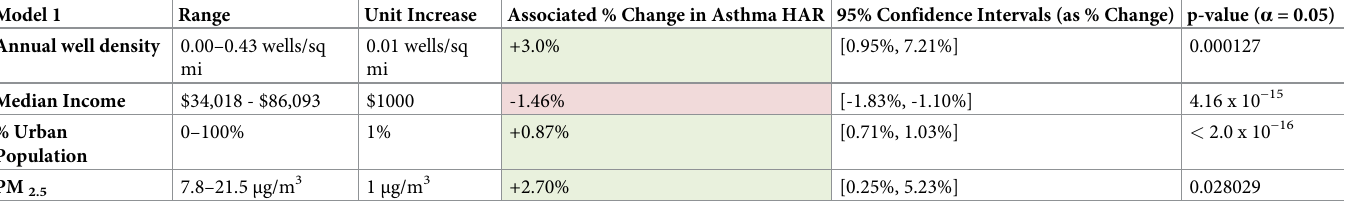
Table 1. Results of the multiple linear regression model using the 62 of the 67 counties in PA that report asthma HAR to investigate the relationship between UNGD and asthma hospitalization.